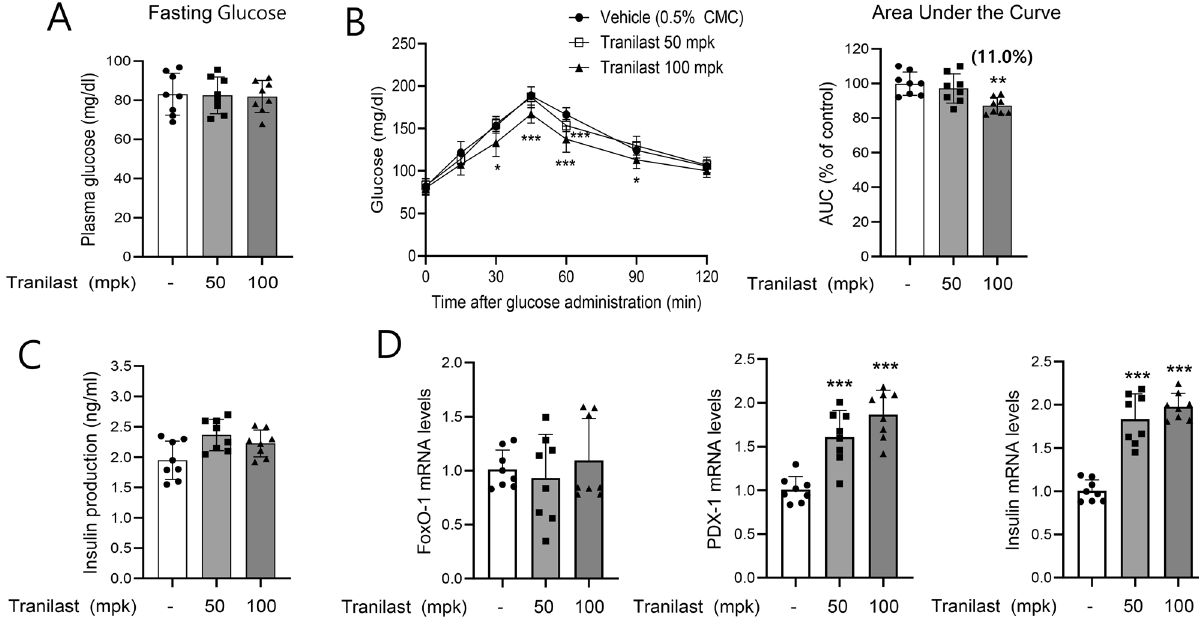
Figure 7. Acute in vivo effect of tranilast was studied using C57BL/6J mice. Male C57BL/6J mice (6-weeks old) were orally administered either vehicle (0.5% CMC) or tranilast (50 and 100 mg/kg, n = 8 per group) at three time points (9 AM, 7 PM, and 9 AM on the 2nd day). (A,C) Fasting glucose and insulin levels were determined after overnight fasting, and glucose tolerance test was carried out (B) . (D) mRNA levels of PDX-1, insulin, and FoxO-1 in whole pancreas were measured by real-time qPCR. * p < 0.05, ** p < 0.01, *** p < 0.005 versus vehicle